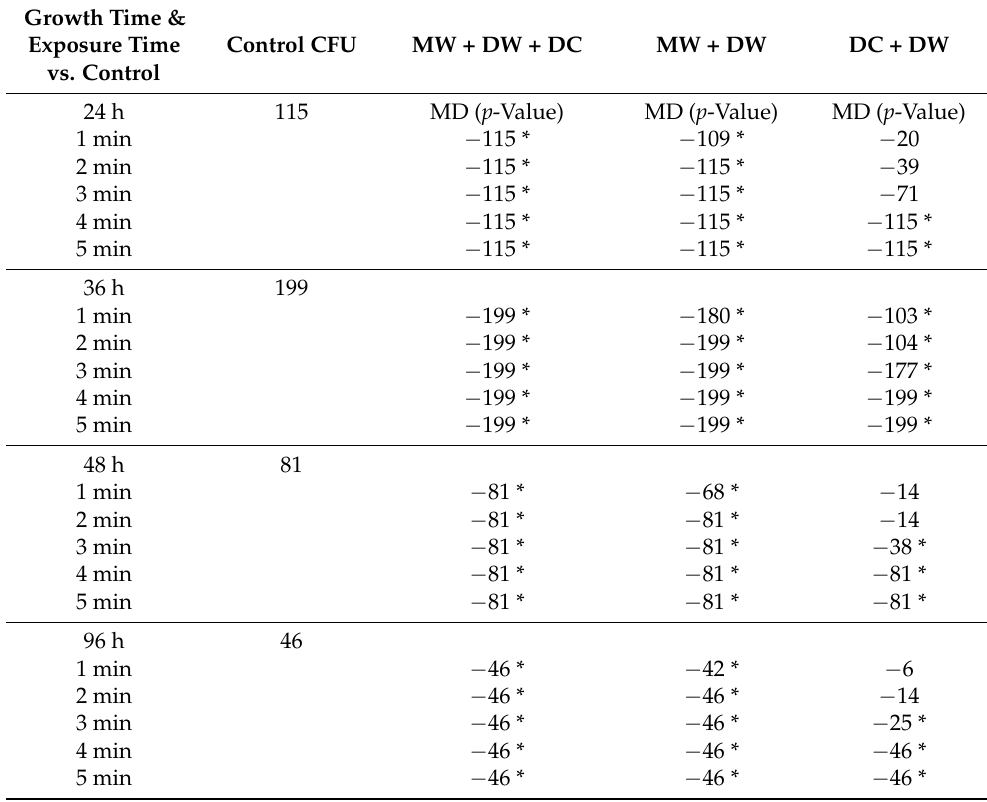
Table 3. Presenting Mean CFU difference among the test and control (non-disinfected) samples for S. mutans . Growth Time & Exposure Time